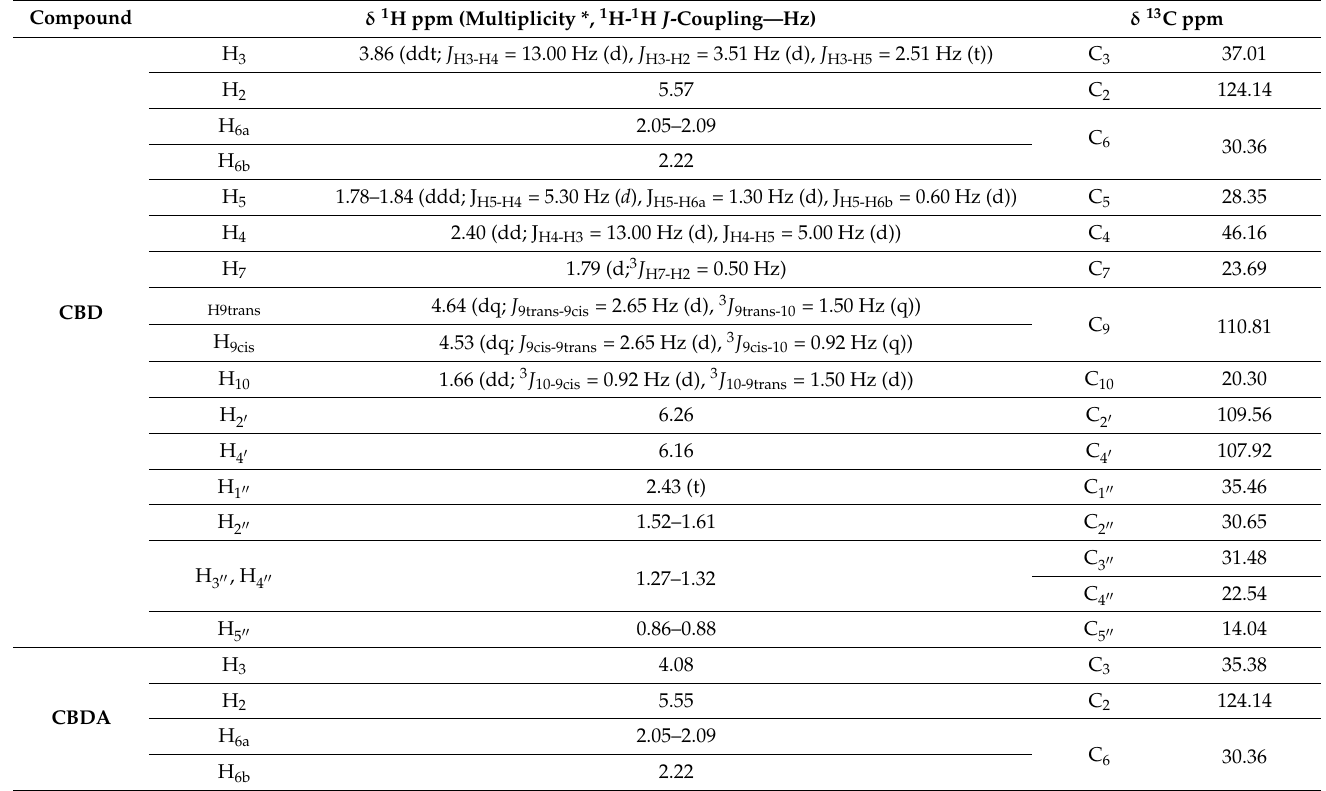
Table 2. 1 H and 13 C chemical shifts of the main cannabinoids in the flower extracts of Cannabis sativa ( Tiborszallasi variety) in CDCl 3